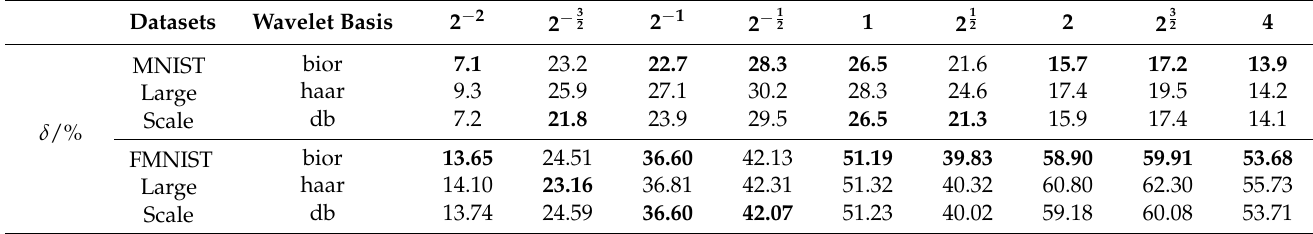
Table 2. Performance for scale estimation against different scales on different datasets.